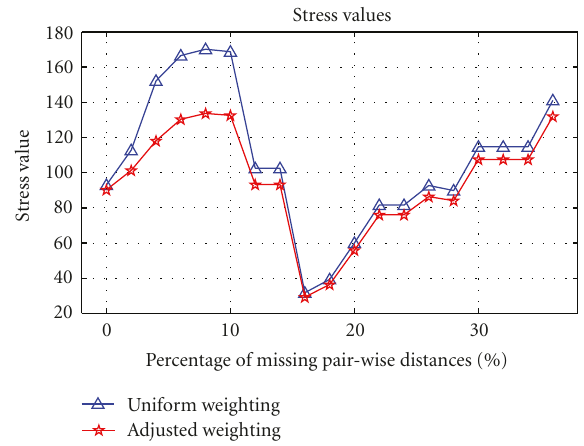
Figure 18: The application of a weighting matrix adjusted using the standard deviation of the measured data contributes to a lower stress value (as expressed in (2)) in the